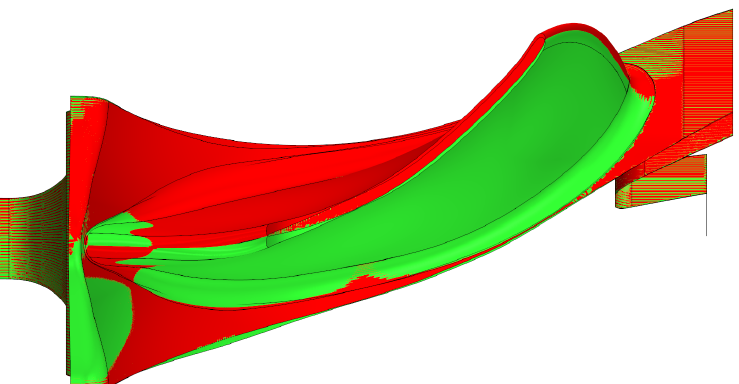
Figure 15. Optimization run.